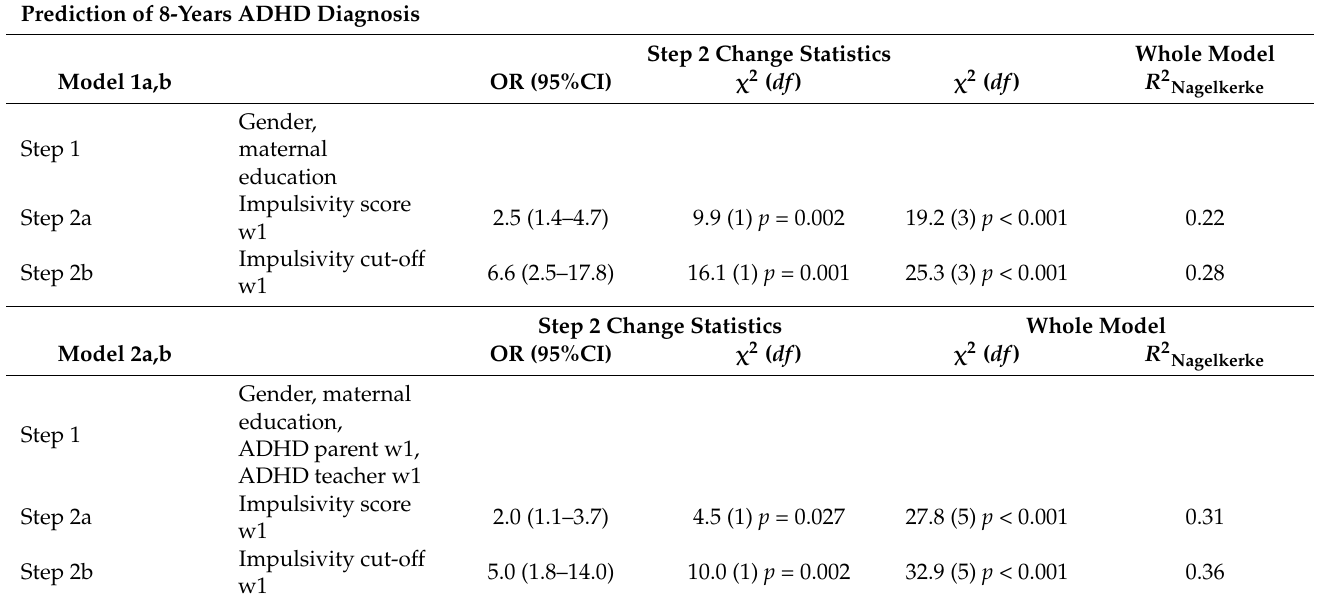
Table 5. Study 2: Logistic regression analyses on the prediction of 8-years ADHD by impulsivity (score and cut-off). Prediction of 8-Years ADHD